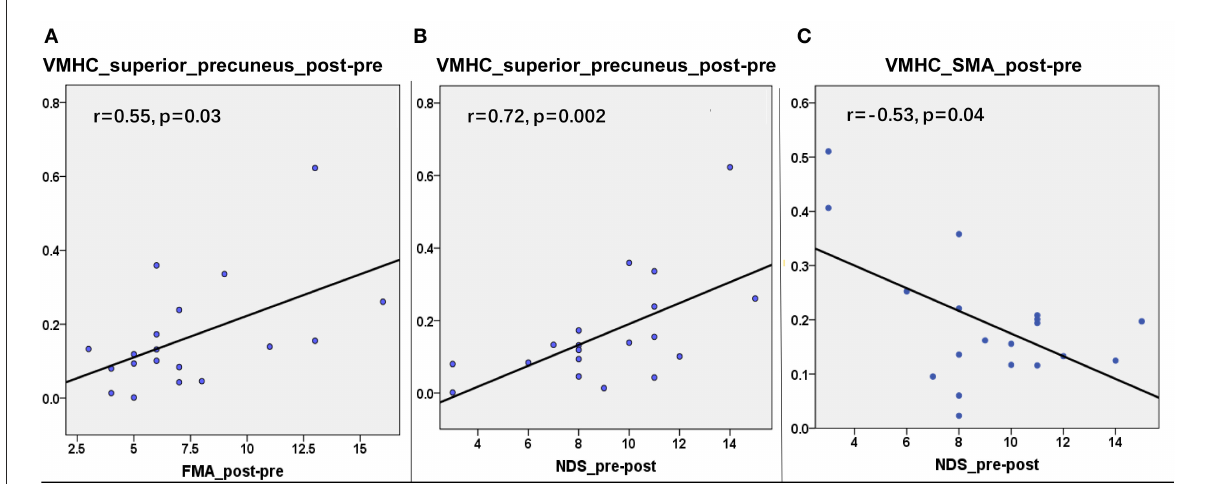
FIGURE4 The correlations between the changes in VMHC and the changes in clinical variables from the first timepoint and the second timepoint in the superior precuneus of stroke patients. (A) The correlation ( r = 0.55, p = 0.03) between the changes of VMHC in superior precuneus and the changes of FMA. (B) The correlation ( r = 0.72, p = 0.002) between the changes of VMHC in superior precuneus and the changes of NDS. (C) The correlation ( r = − 0.53, p = 0.04) between the changes of VMHC in SMA and the changes of NDS.